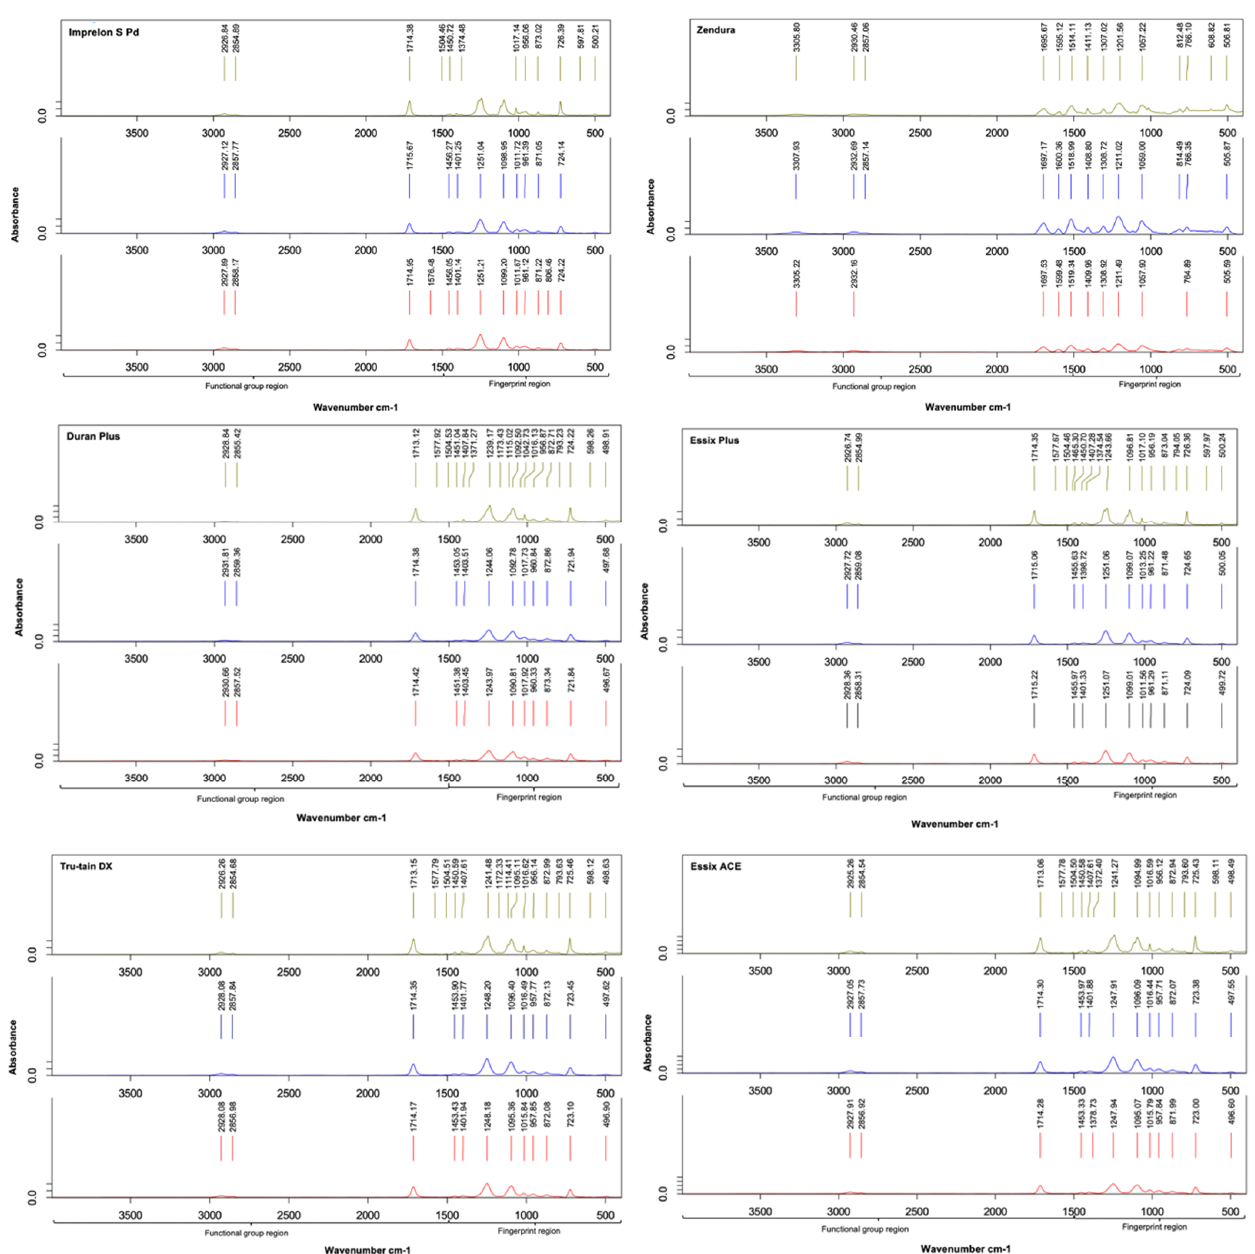
Figure 9. Superimposition of FTIR spectra of Group 1: before thermoforming (green), Group 2: after thermoforming (blue), and Group 3: after thermoforming and subsequent thermocycling (red) of each investigated retainer material.